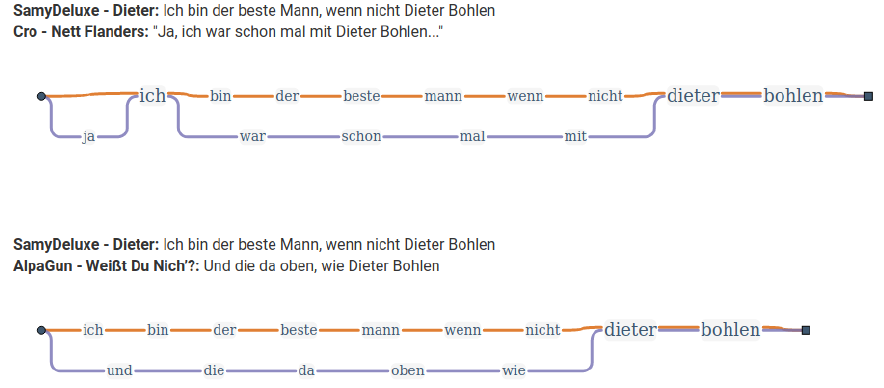
Figure 5. Two of the nearest neighbors of a line by Samy Deluxe displayed with TraViz.